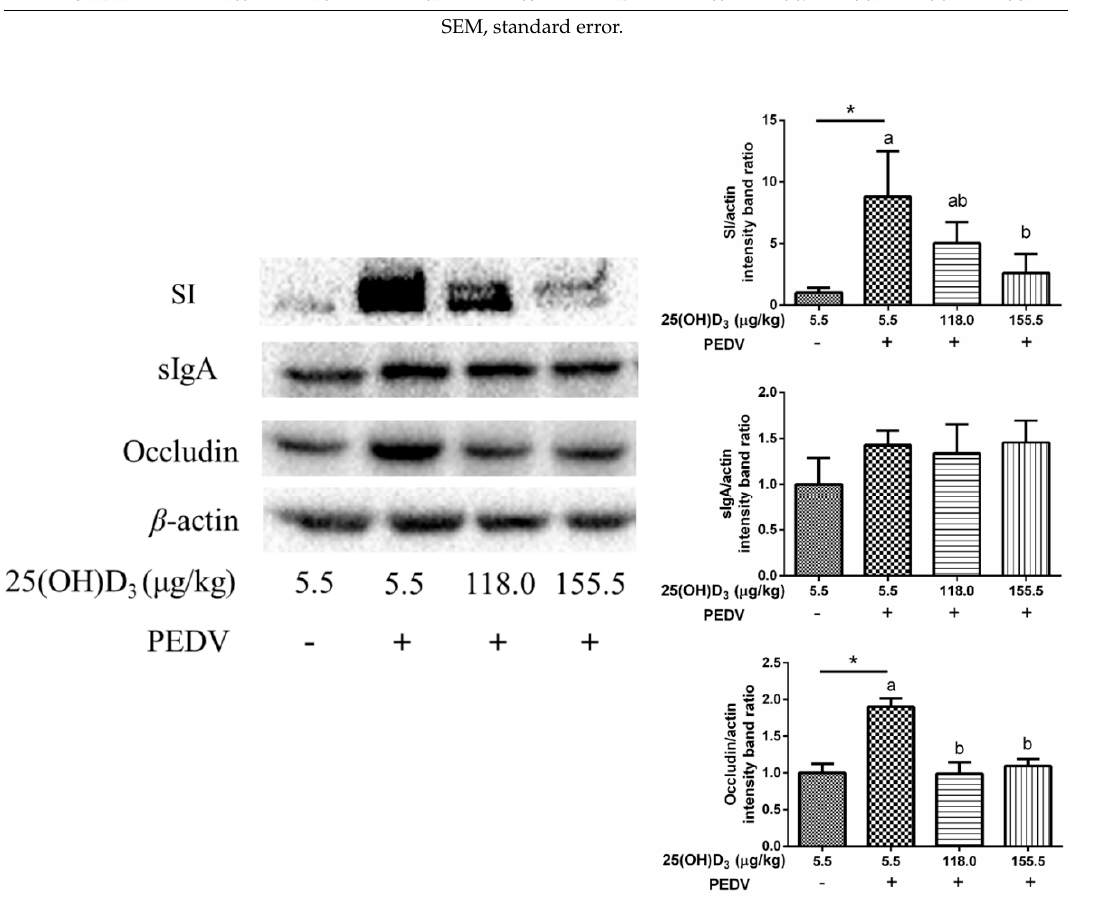
Figure 2. Intestinal barrier related protein expression in the jejunal mucosa of weaned piglets fed indicated 25(OH)D 3 dietary with PEDV challenge. Table 7. Relative gene expression of innate immune in the jejunal mucosa of weaned piglets fed 25(OH)D 3 as indicated with PEDV challenge.